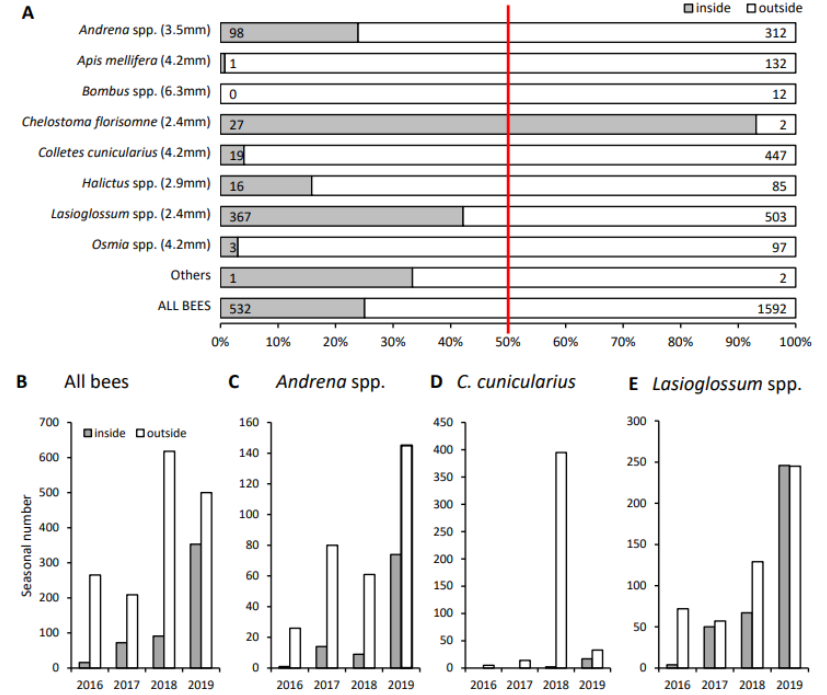
Figure 2. Bees (Hymenoptera: Apidae) collected in coloured pan traps placed inside and outside the netted plot of apple trees during the flowering period in the years 2016–2019. ( A ) Relative abundance of different genera or species. The red line indicates equal numbers inside and outside. Absolute numbers are displayed in the bars. The average thorax width (mm) is given next to species names. The lower panels represent yearly numbers of ( B ) all bees, ( C ) Andrena spp., ( D ) Colletes cunicularius , and ( E ) Lasioglossum spp.